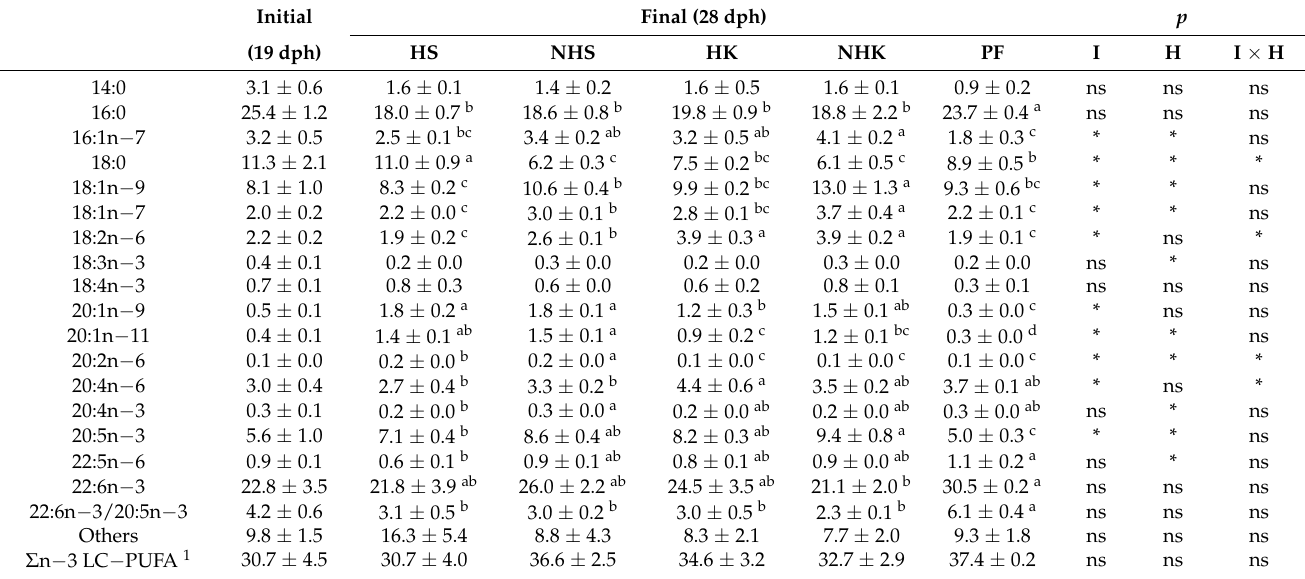
Table 8. Fatty acid composition (area% of total lipid) of whole fish body of Pacific bluefin tuna for 9